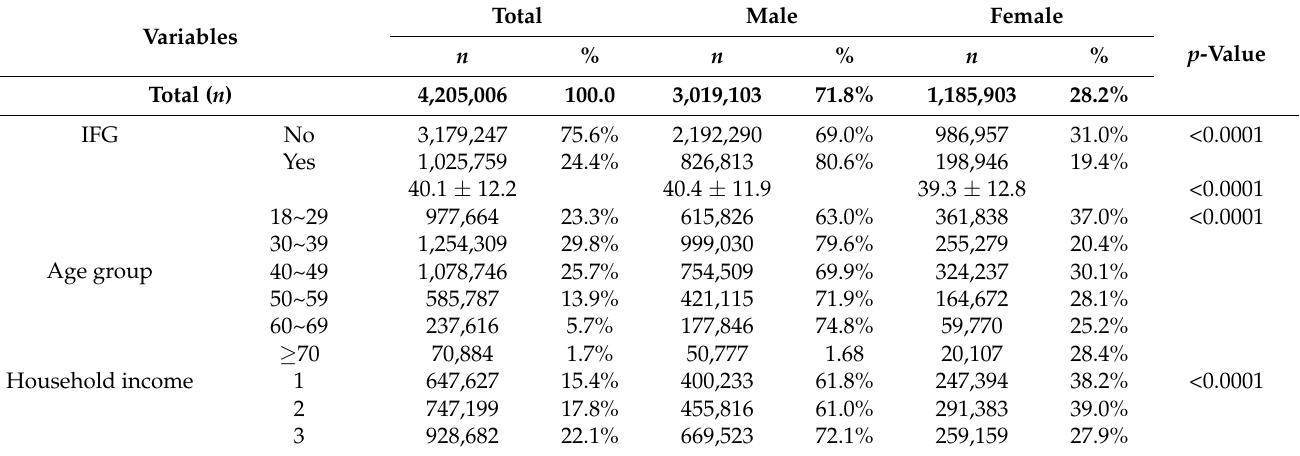
Table 1. Characteristics of the